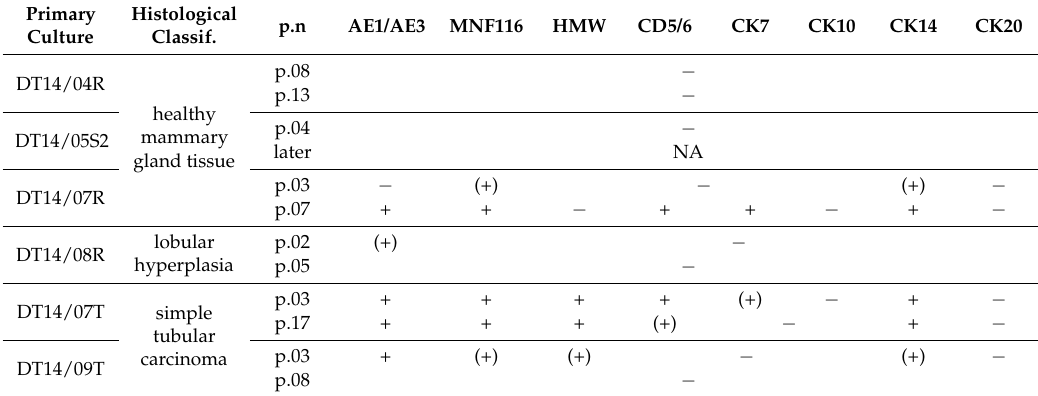
Table 2. This table shows the cytokeratin (CK) distribution of the primary cultures. “Histological Classif.” refers to the histological classification of the original tissue samples from which the primary cultures were derived, “p.n” refers to a certain passage, “AE1/AE3” refers to Pan-CK (CK1-8, CK10, CK13-16, CK19), “MNF116” refers to Pan-CK (CK5, CK6, CK8, CK17, CK19), “HMW” refers to Pan-CK (CK1, CK5, CK10, CK14). “+” refers to positivity, “(+)” to a weak positivity and “ − ” refers to negativity for protein distribution. “NA” refers to not